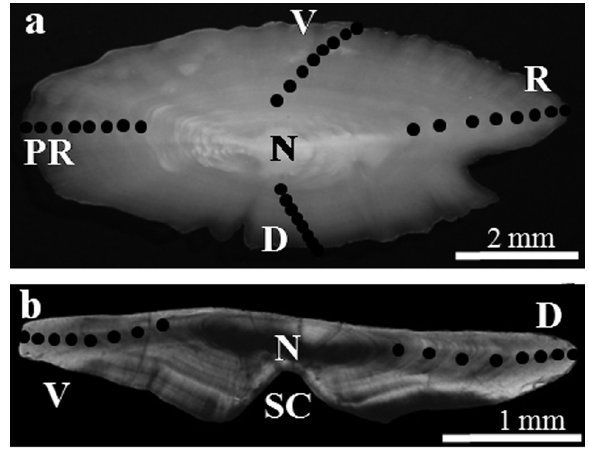
Fig . 2. – number of growth increments observed between different areas of the same otolith and between whole and sectioned otoliths from Aphanopus carbo caught off mainland Portugal. Black dots represent growth increments. (a) left whole otolith (specimen with 1083 mm total length and 8 years). (b) equivalent right sectioned otolith. PR: posterior region; V: ventral face; R: rostrum; d: dorsal face; sC: sulcus acusticus ; n: